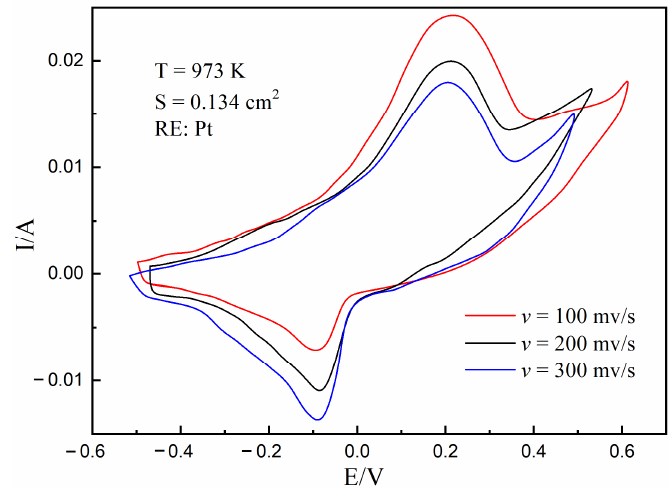
Figure 1. Typical CV curves for different scan rates.